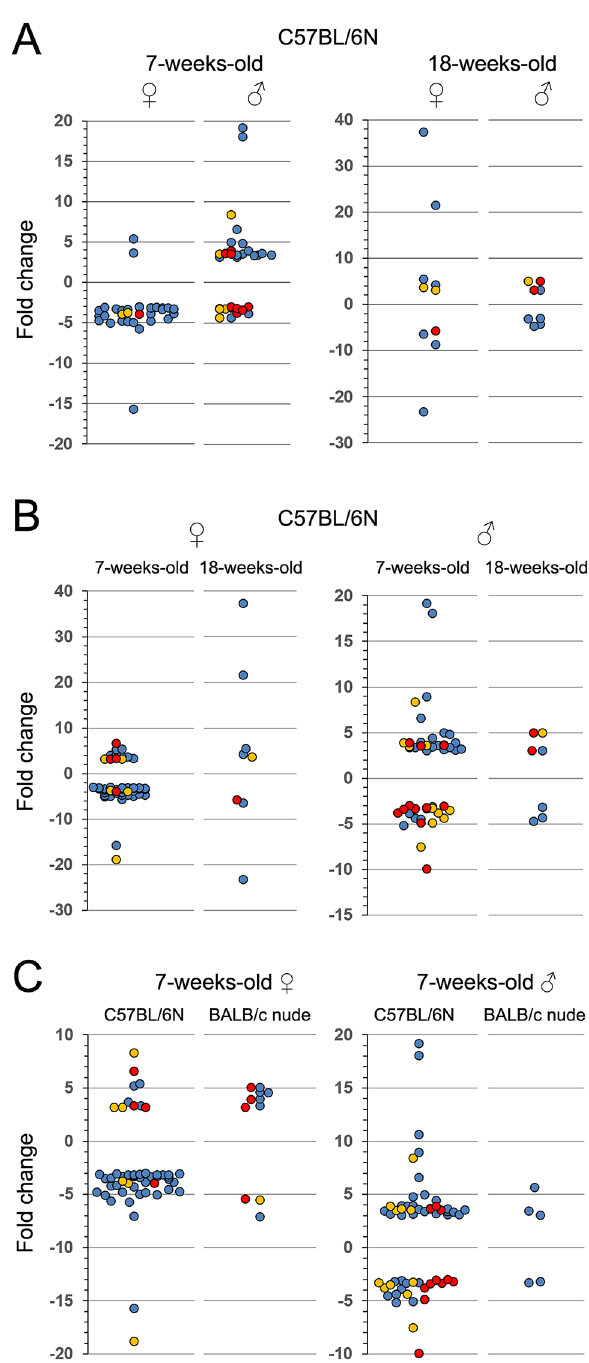
Figure 5. Pairwise comparison of fold change distribution for differentially abundant proteins unique for each age, sex and strain group. Proteins (dots) with differential abundance (|FC|≥ 3) in blood plasma 24 h after 0.5 Gy total body irradiation were associated with Gene Ontology terms; selected ionizing radiation-induced responses are shown, i.e. immune response (blue), cell cycle (yellow), and DNA damage and repair (red). Sex difference for each age group ( A ), age difference for each sex ( B ), and strain difference for each sex (juveniles, 7-weeks-old) ( C ). Note difference in scaling of y-axis. ♀ , female; ♂ , male. Please note that presented data is normalized to respective unirradiated control